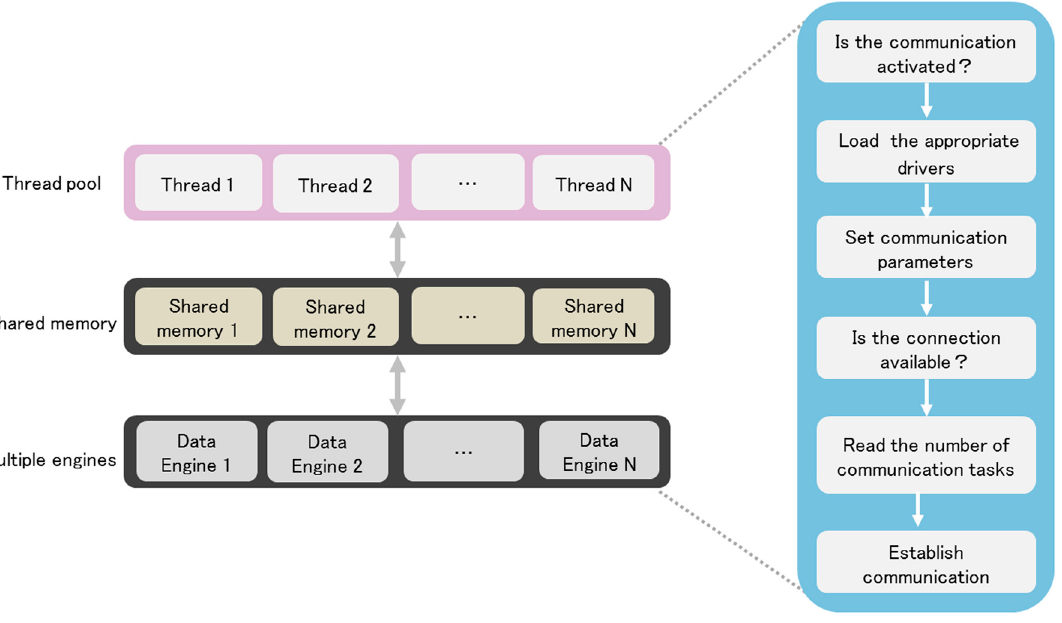
Figure 5. Workflow of the communication driver.